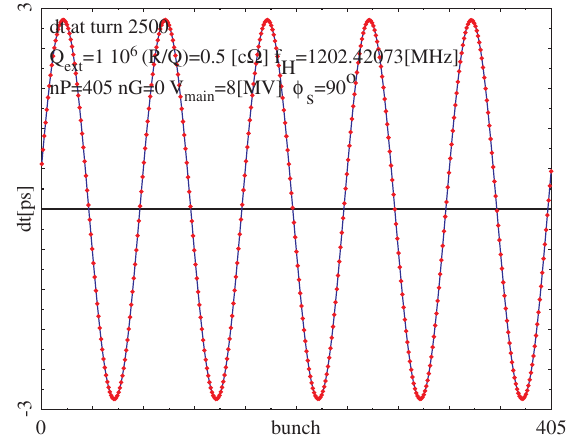
FIG. 4. (Color) Program check: Snapshot of the longitudinal position deviation dt n of all 405 bunches (red dots, adjacent ones linked by a blue line) along the machine